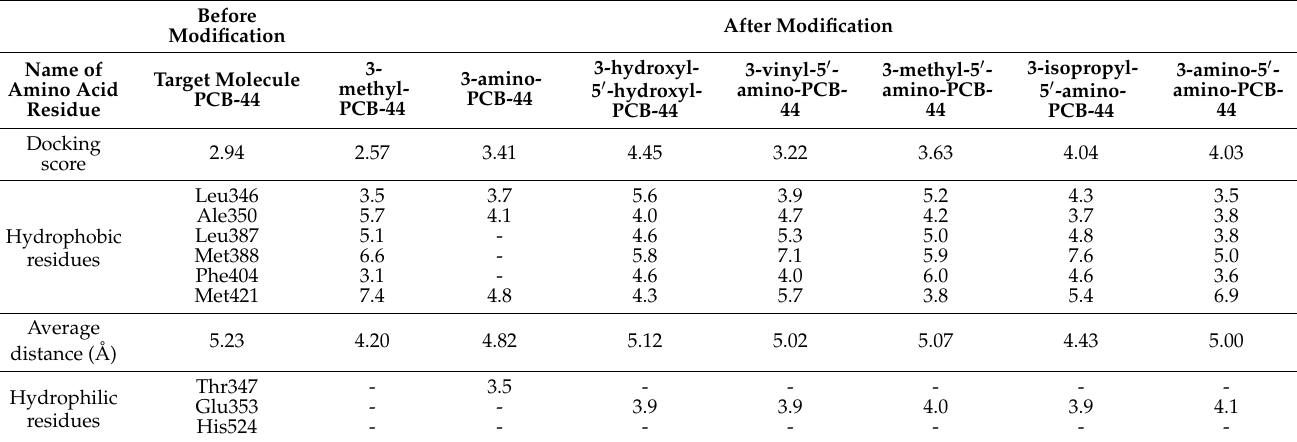
Table 5. Distance between the hydrophobic substituents of PCB-44 and its new molecules and the hydrophobic amino acid residues at the binding site of hER α (PDB ID: